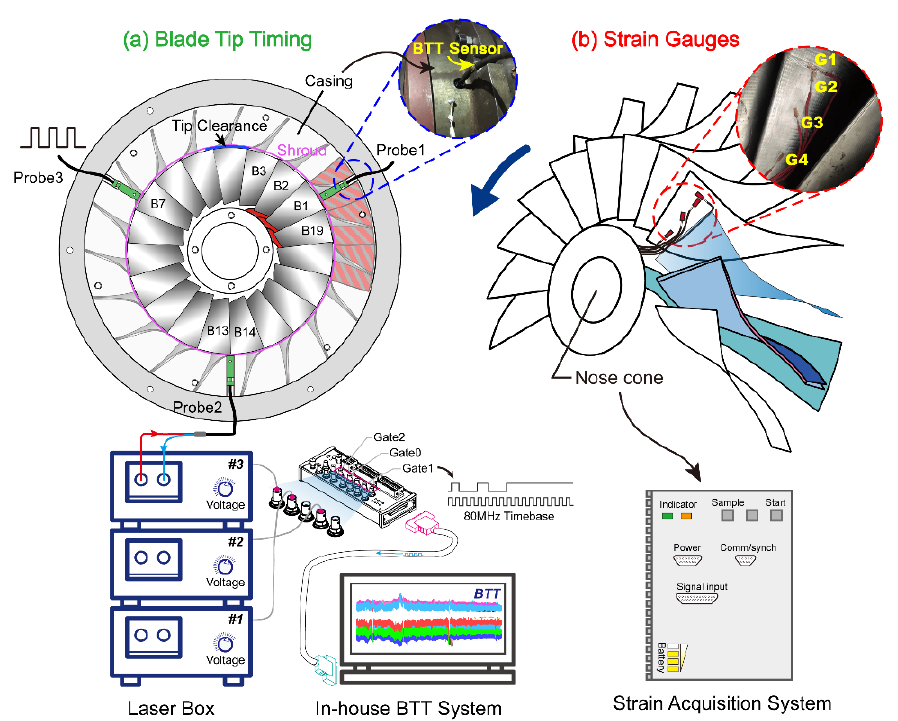
Figure 6. Installation and arrangement of tip timing probes ( a ) on the casing and strain gauges ( b ) on one impeller blade